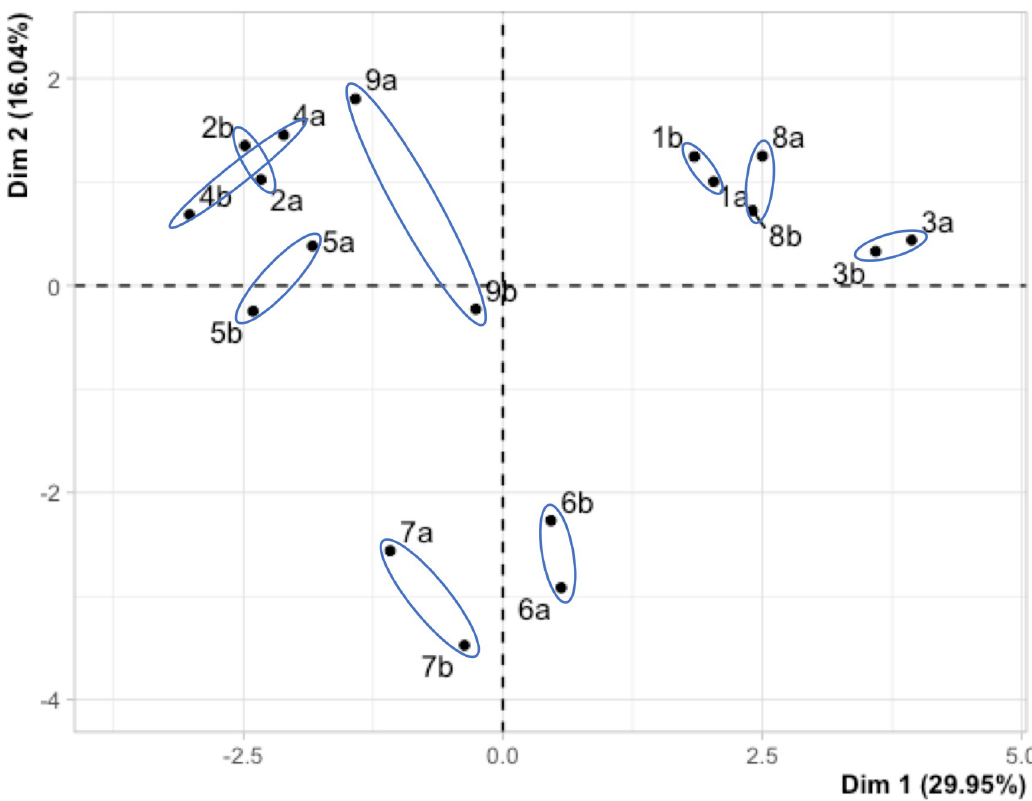
Fig 4. Scores plot from PCA on sensor array responses after 48 h deployment in 9 households. Two sensors were deployed in each household (labelled (a) and (b)) and are linked by the blue ovals overlaid on the plot.